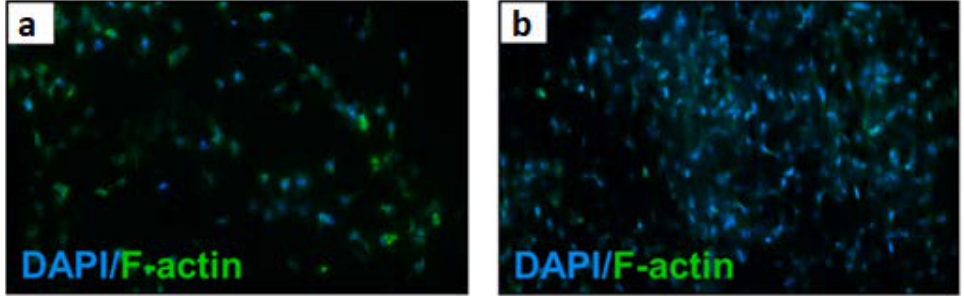
Figure 8. Confocal microscopy images ( a , b ) of fibrous scaffolds with ATDC5 cells after three-day culture with piezoelectric stimulation. Reprinted from [98] with permission from Elsevier.